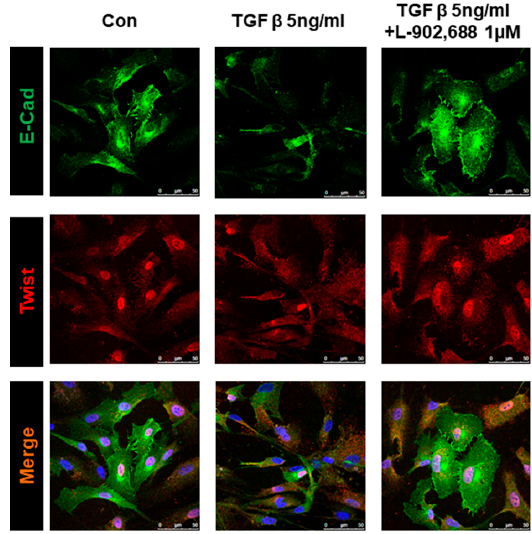
Figure 3. Effect of L-902,688 on TGF- β -induced Twist expression in HUVEC . After 24 h of serum deprivation, endothelial cells were treated under the indicated conditions for 24 h. Immunocytochemistry shows the localization of Twist (red) and E-cadherin (E-cad) (green) expression (nuclear staining with DAPI in blue; scale bar: 50 µm). The images are a representative of three independent experiments.